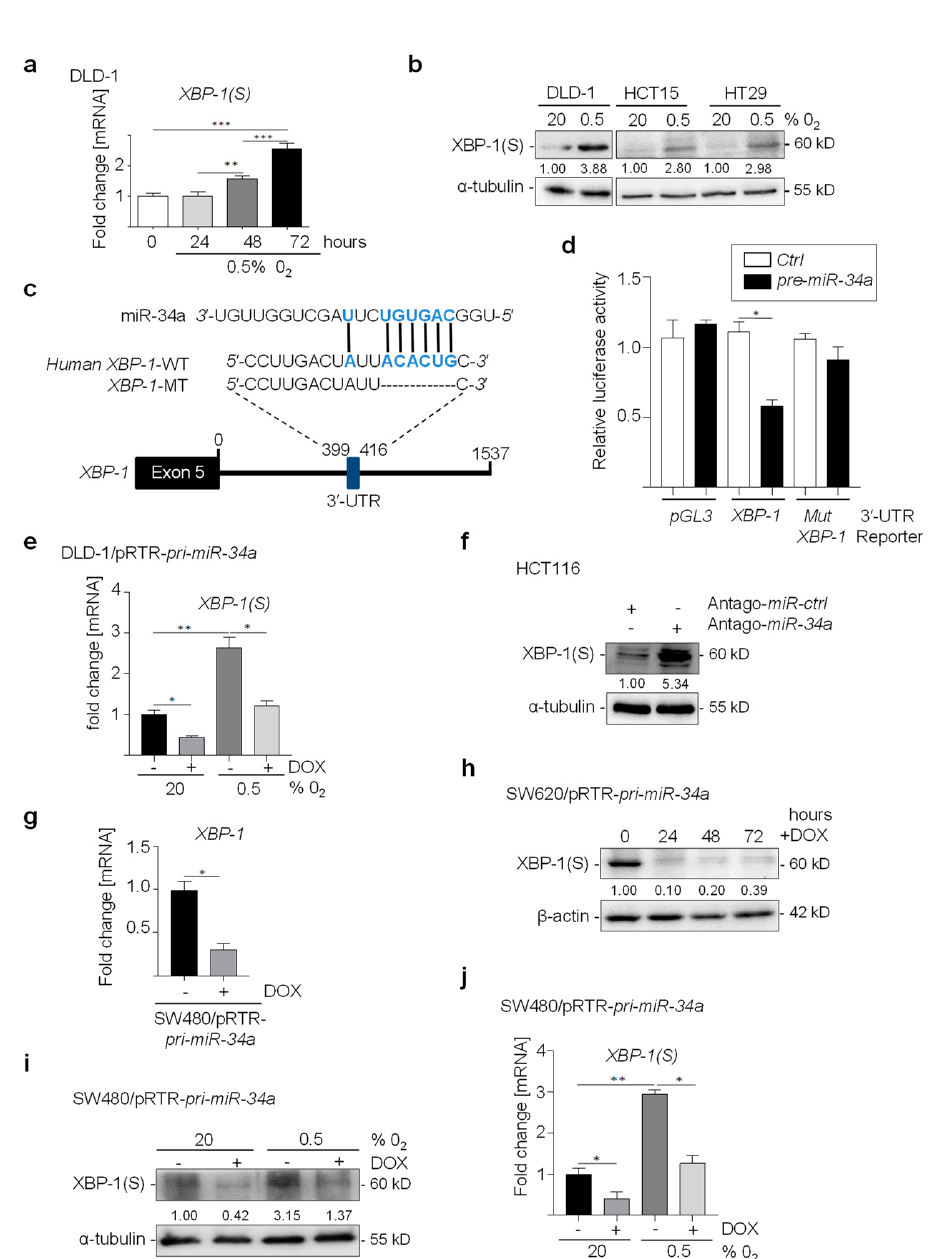
Figure 1. Hypoxia-induced XBP-1 is repressed by miR-34a. ( a ) qPCR analysis of XBP-1(S) in DLD-1 cells exposed to 20% or 0.5% O 2 for the indicated times. ( b ) Western blot analysis of XBP-1(S) in DLD-1, HCT15, and HT-29 cells exposed to 20% or 0.5% O 2 for 72 h. ( c ) Schematic representation of the XBP-1 3 (cid:48) -UTRs indicating the miR-34a seed-matching sequences (SMS) and its mutagenesis. The vertical bars indicate possible base pairing. ( d ) Dual reporter assay after transfection of H1299 cells with pre-miR-34a oligonucleotides and human XBP-1 3 (cid:48) -UTR reporter constructs. ( e ) qPCR analysis of XBP-1(S) in DLD-1 cells harboring a pRTR/ pri-miR-34a vector after addition of DOX and exposed to 20% or 0.5% O 2 for 72 h. ( f ) Western blot analysis of XBP-1(S) in HCT116 cells transfected with antago-miR-34a or antago-miR negative control oligonucleotides. ( g ) qPCR analysis of XBP-1 in SW480 cells harboring a pRTR/ pri-miR-34a vector after addition of DOX for 48 h. ( h ) Western blot analysis of XBP-1(S) and XBP-1(U) in SW620 cells harboring a pRTR/pri-miR-34a vector after addition of DOX. ( i , j ) Western blot and qPCR analysis of XBP-1(S) in SW480 cells harboring a pRTR/ pri-miR-34a vector after addition of DOX and exposure to 20% or 0.5% O 2 for 72 h. In panel ( a , d , e , h , j ) mean values ± SD (n = 3) are provided. (***) p < 0.001, (**) p < 0.01, (*) p < 0.05.